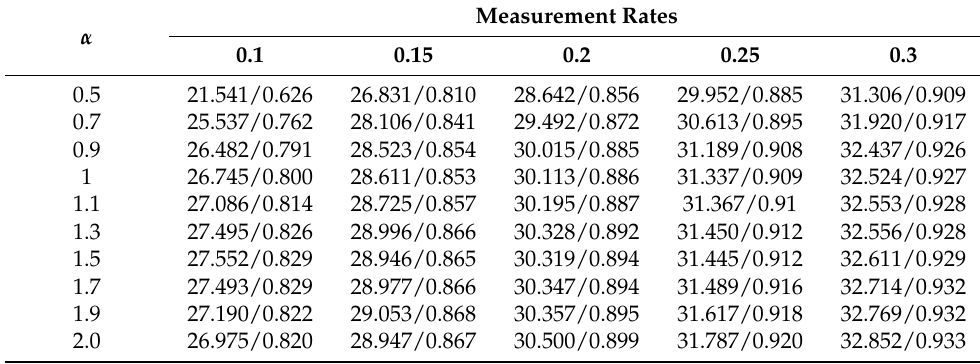
Table 5. PSNR (dB)/SSIM results for the different fractional-order for the Lena